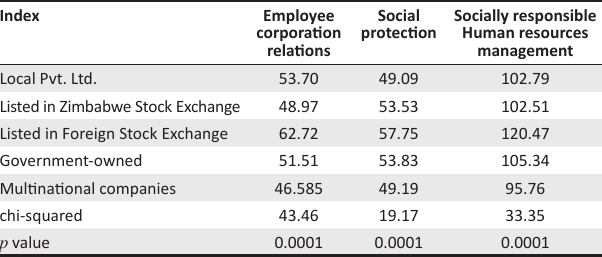
TABLE 6: Composite indices for socially responsible human resources